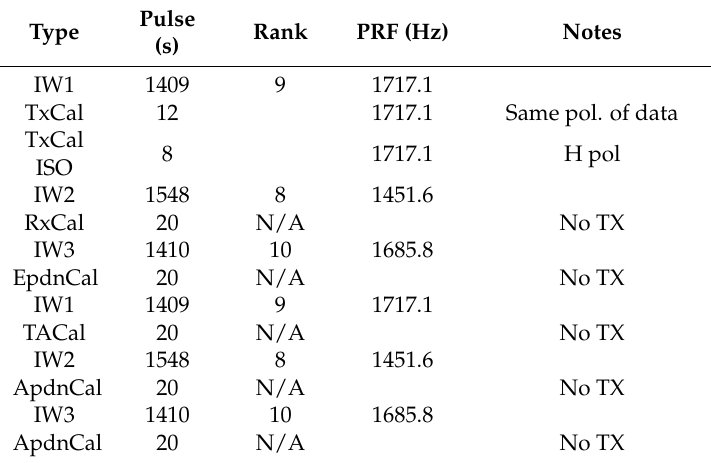
Table 1. IW timeline, cyclically